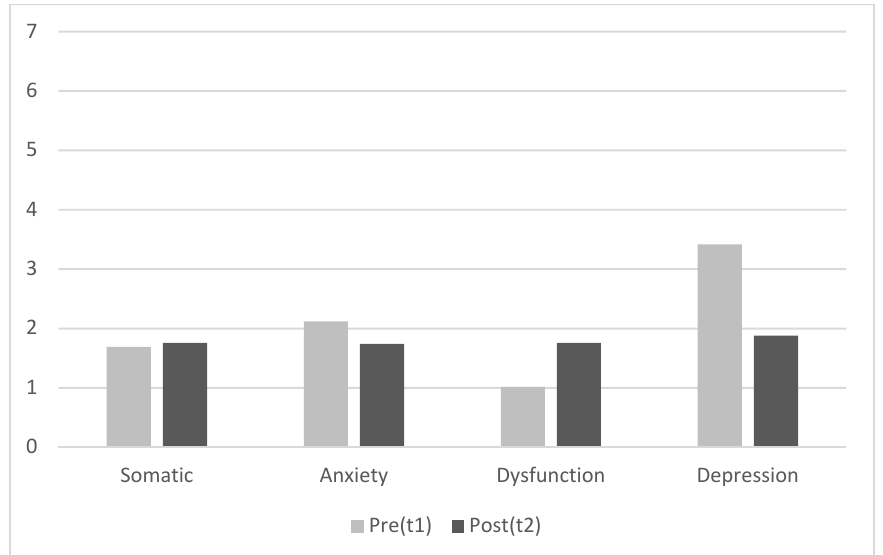
Figure 1. Cheerfulness and seriousness scores both before and after training (N = 58). For clarity, the Y -axis shows mean scores (not mean ranks).